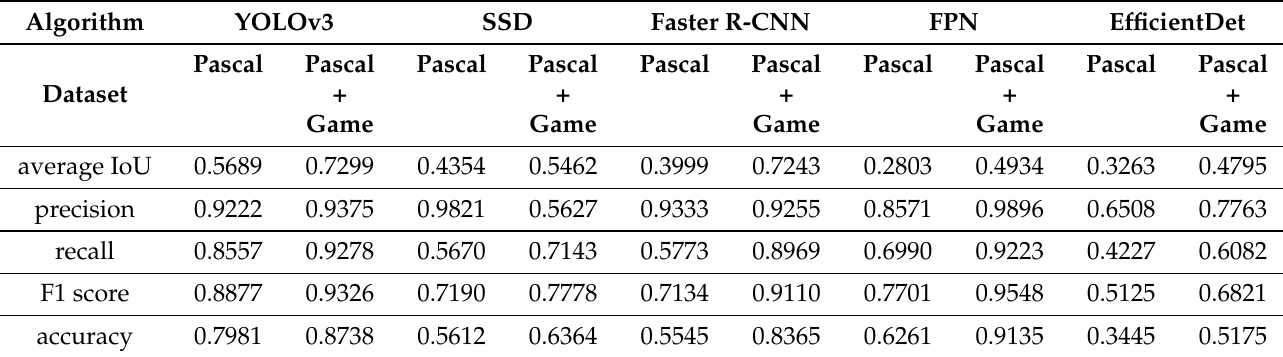
Table 6. The statistics. We compared the algorithms trained by PascalVOC and retrained by PascalVOC with game scenes for five object detection algorithms. Note that PascalVOC is abbreviated as Pascal in the table.